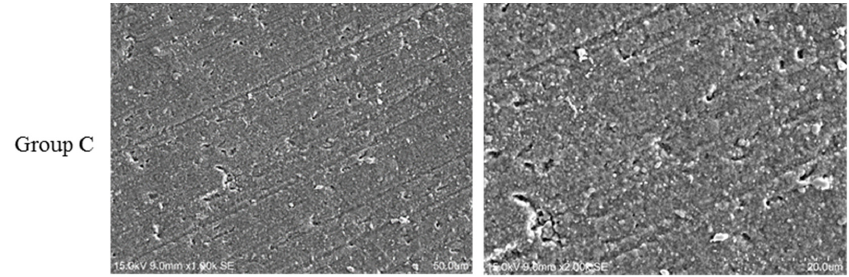
Figure 1. Cont. Figure 1.